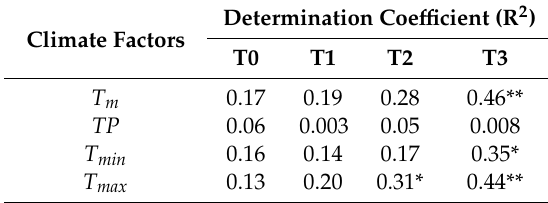
Table 3. The time lag effects of GUD responses to climatic factors for 2001–2015 on a regional scale. Climate factors